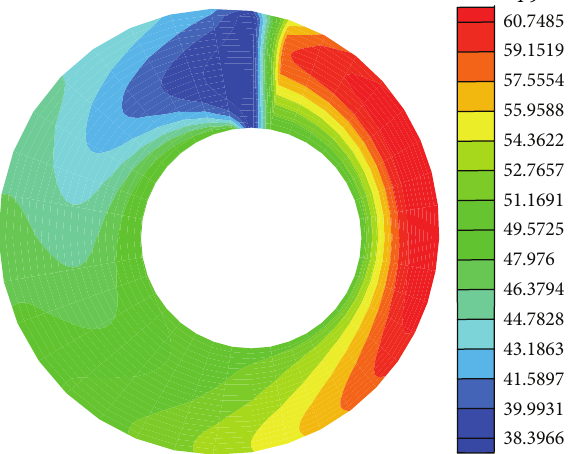
Figure 14: Isothermal lines of the journal bearing at its central plan for 𝜀 = 0.3 and 𝑛 = 1.1 .